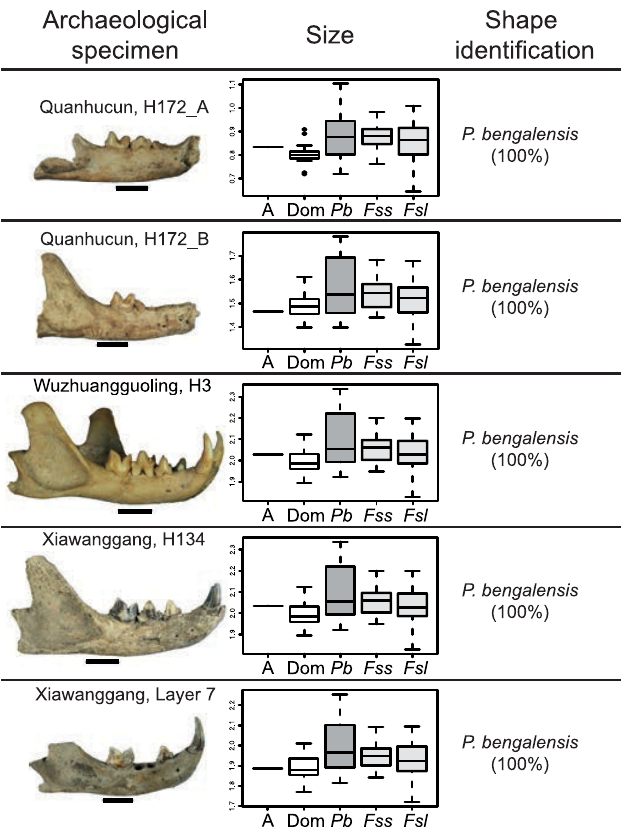
Fig 2. Geometric morphometric analyses of the five archaeological Chinese cat mandibles. Left column: lateral view of the mandibles — the first and the fourth specimens being transposed right side left, the scale bare represents 1cm. Middle column: Boxplot comparison of centroid size of the archaeological specimen (A), with those of modern: domestic cat (Dom), leopard cat ( Pb ), European wildcat ( Fss ) and SW Asian wildcat ( Fsl ). Right column: species identification of the specimen based on discriminant analyses computed on mandible shape variables. Percentages within brackets correspond to the probability of being identified as Pb